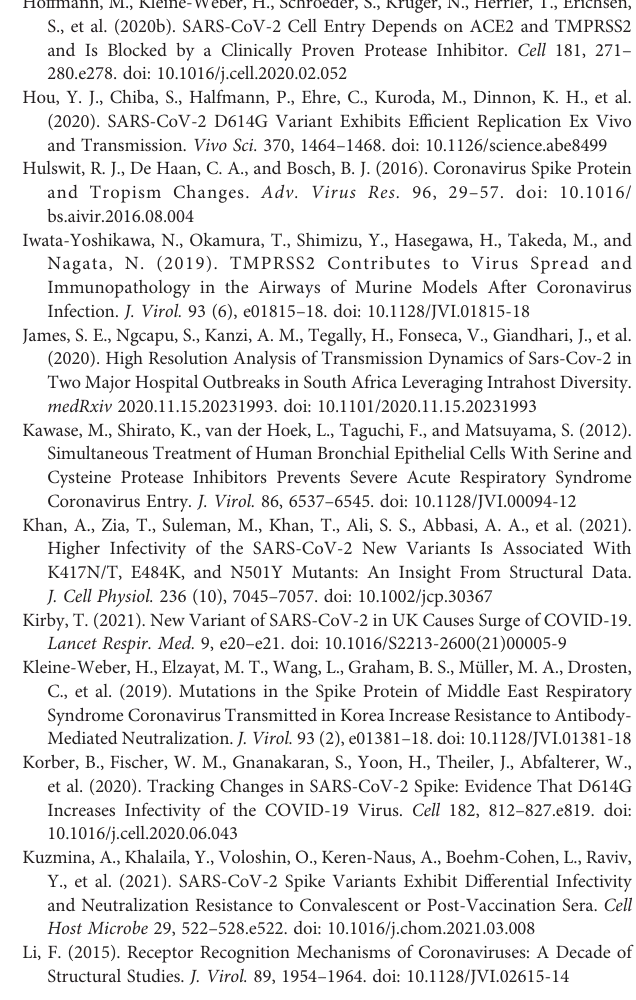
(C) , Caco2 (D) , Caco2-hACE2 (E) cells. ns represents no signi fi cant difference, p < 0.05 (*), p < 0.01 (**), p < 0.001 (***), p < 0.0001 (****). Supplementary Figure 3 | SARS-CoV-2 N501Y.V2 is more thermal stable than WT and D614G. SARS-CoV-2 WT, D614G, N501Y.V2 and N501Y.V2 RBD S pseudovirions were incubated in cell culture medium DMEM at 37°C for 4 h (A) and 6h (B) or42°Cfor4h (C) and6h (D) .Theviruseswerequanti fi edfortheirinfectious levels by luciferase on 293T-hACE2 cells. The infection ef fi ciency of remaining viruseswerenormalizedbytheaverage fl uorescencevaluesat0h.nsrepresentsno signi fi cant difference, p < 0.05 (*), p < 0.01 (**), p < 0.001 (***), p < 0.0001 (****). Supplementary Figure 4 | The effects of protease and endocytosis pathway inhibitors on the entry of SARS-CoV-2 N501Y.V1 and N501Y.V2 RBD. (A, B) Effect of CatB/L or TMPRSS2 on SARS-CoV-2 N501Y.V1 and N501Y.V2-RBD entry into host cells. E64d (0.4 m M), Camostat (50 m M) or the combination of them (E64d (0.4 m M) + Camostat (50 m M)) were added into 293T-hACE2 (A) or 293T-hACE2- TMPRSS2 (B) cells 2 h prior to transduction. The luciferase activity was measured 24hposttransduction. (C,D) EffectofendocytosisonSARS-CoV-2N501Y.V1and N501Y.V2 RBD entry into host cells. Endocytosis inhibitors Chloroquine (1 m M), Tetradeine (0.2 m M), and Apilimod (5 nM) were added into 293T-hACE2 (C) or 293T-hACE2-TMPRSS2 (D) cells 2 h prior to transduction. Experiments were done in 4 replicates and repeated at least twice. One representative is shown with error bars indicating SEM. ns represents no signi fi cant difference, p < 0.05 (*), p < 0.01 (**), p < 0.001 (***), p < 0.0001